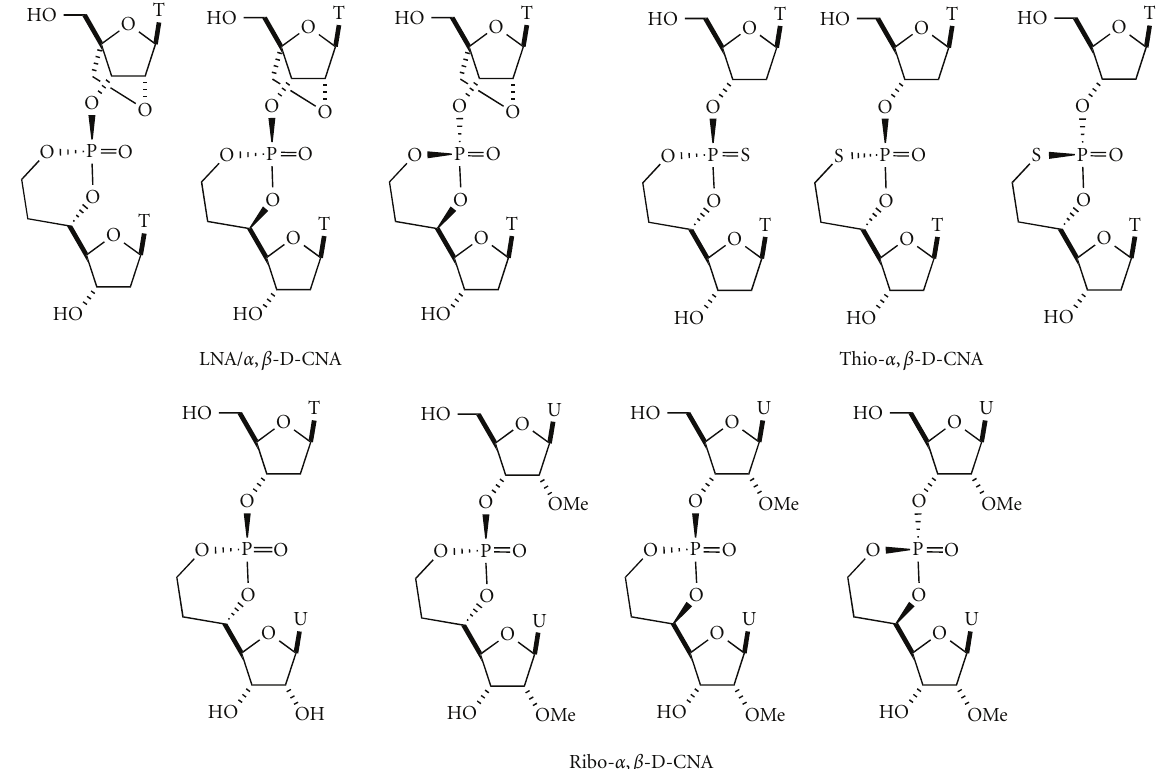
Figure 4: LNA-, thio-, and ribo - α , β -